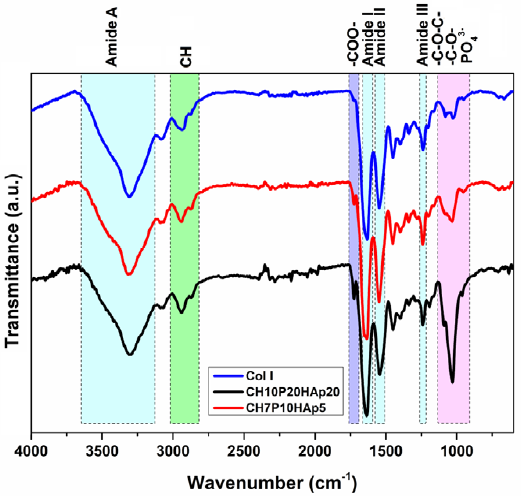
Figure 7. Typical FTIR spectra of the included construct layers of different compositions. The level of crosslinking was increased by increasing the content of PCL-diA relative to Col I, by adding proteoglycan that was able to act as a crosslinker (due to development of specific electrostatic interactions and H bonds) [40] and polyethylenimine-coated nHAp, thus affecting the morphology, swelling, and mechanical behavior of the 3D structures. During cryogelation, the aza-Michael addition reaction occurred at a temperature below the freezing point of the reaction solution (mixture of water, DMSO, and acetone), thus creating an apparently frozen system consisting of ice crystals and microchannels of unfrozen liquids. The crystals formed as the solvent mixture freezes acted as irregular pore formers, with the generation of an interconnected porous structure consisting of both isolated and large interconnected pores. As much of the solvent mixture freezes, the components used in making these cryogels accumulated in the unfrozen liquid microphase (microchannels) and formed the crosslinked walls around the crystals. As evidenced by SEM image analysis, Figure 8, a decrease in average pore sizes from 230 µ m (sample 2/CP7) to 112–131 µ m (samples 7 and 9), 118 µ m (sample 4), 95 µ m (sample 6), 85 µ m (sample 8), 76 µ m (sample 3), and up to 74 µ m (sample 5) was noticed. Thus, layers with different pore sizes can be easily obtained by choosing the appropriate recipe composition. The inclusion of nHAp along and between the collagen fibrils, coated with PCL, can be clearly observed in Figure 8C. This aspect agrees with the increased ordering level observed by the FTIR spectra for samples 5 and 6 (CH10P20HAp20 and CH7P10HAp5, Table 1). By including glycosaminoglycans and nHAp LPEI , as well as by increasing the PCL content, the pore walls became thicker from the top to the bottom. The reduced reaction rate due to the low temperature imposed the extension of the reaction time to allow the complete reaction for the fabrication of the cryogel, especially of the multilayered construct. Keeping the construct layers for a longer period of time at sub-zero temperatures allowed the morphology to change (as previously observed [22]), with the appearance of a fibrillar collagen structure in the bottom